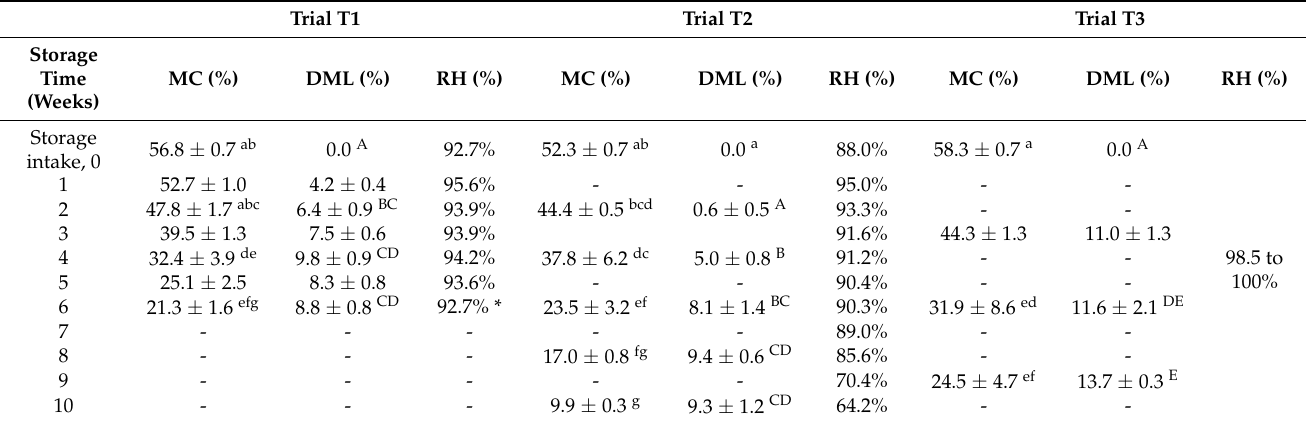
Table 2. MC, DML and RH of poplar chips of the storage trials T1–T3. MC and DML expressed as mean ( n = 6 and n = 3 at the storage intake and storage times, respectively) ± standard deviation (SD). Trial T1 Trial T2 Trial